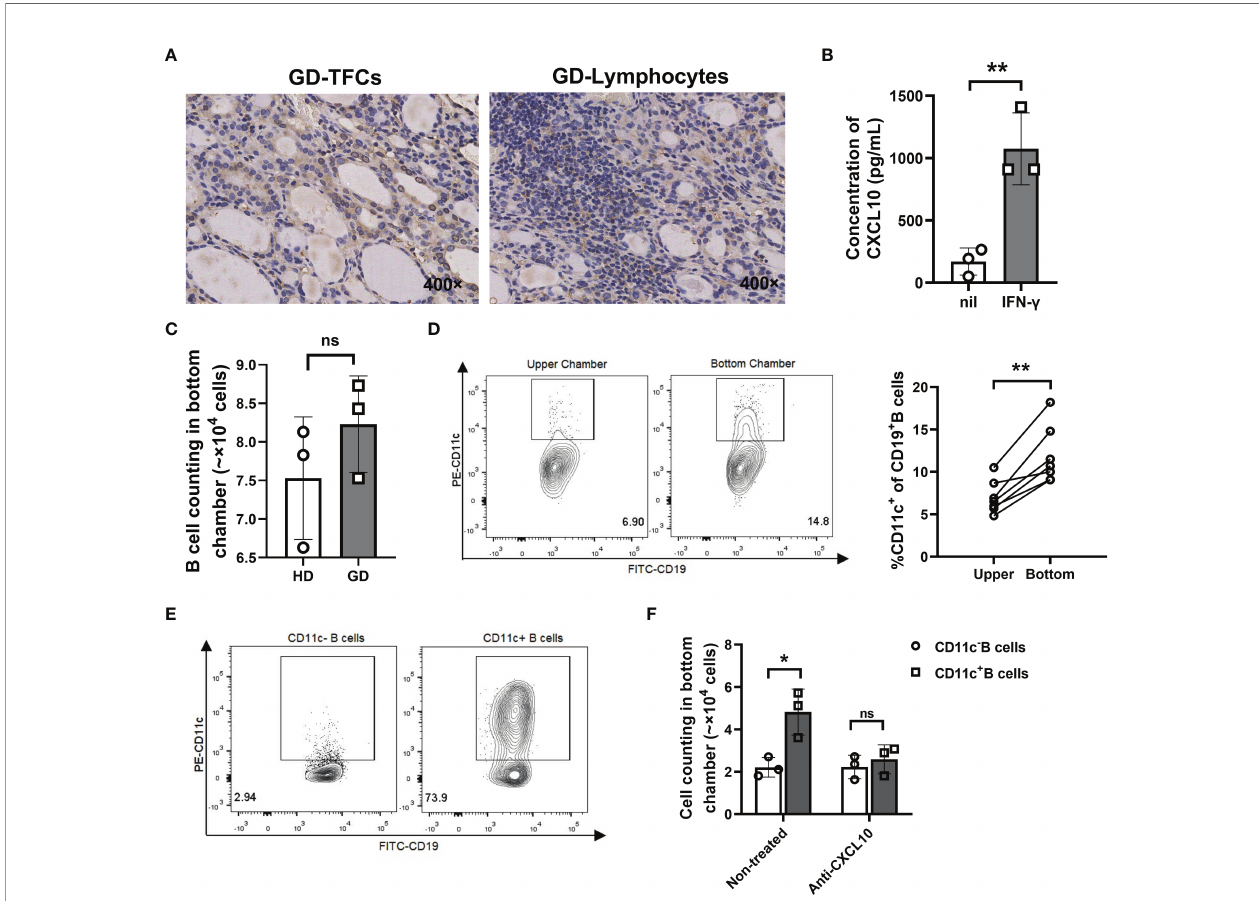
FIGURE 9 | CD11c + B cells were recruited to the thyroid via the CXCR3-CXCL10 axis. (A) Immunohistochemical staining for CXCL10 in thyroid sections from GD patients (400-fold magni fi cation). (B) Concentration of CXCL10 in culture supernatants of Nthy-ori3-1 cells under control conditions or stimulation with IFN- g (1000 U/ ml) for 72 h. (C) Transwell assay performed with total CD19 + B cells from healthy donors (control) and GD patients. After 3 hours, the cells that migrated to the lower chamber were counted. (D) Representative fl ow cytometric plots of CD11c + B cells from the paired upper chamber and lower chamber after 3 h of migration (left). Comparison of the frequency of CD11c + B cells in CD19 + B cells between the paired upper chamber and lower chamber (right). (E) Flow cytometric plots of sorted CD11c - B cells (left) and CD11c + B cells (right) from GD patients. (F) Transwell assays performed with CD11c - B cells and CD11c + B cells from GD patients. Untreated and anti-CXCL10 antibody-treated culture supernatants were added to the lower chamber separately. After 3 h, the cells that migrated to the lower chamber were counted. Data are represented as the mean ± SD, paired or unpaired Student ’ s t test. P < 0.05 was considered statistically signi fi cant. ns, not signi fi cant; * P < 0.05; ** P <